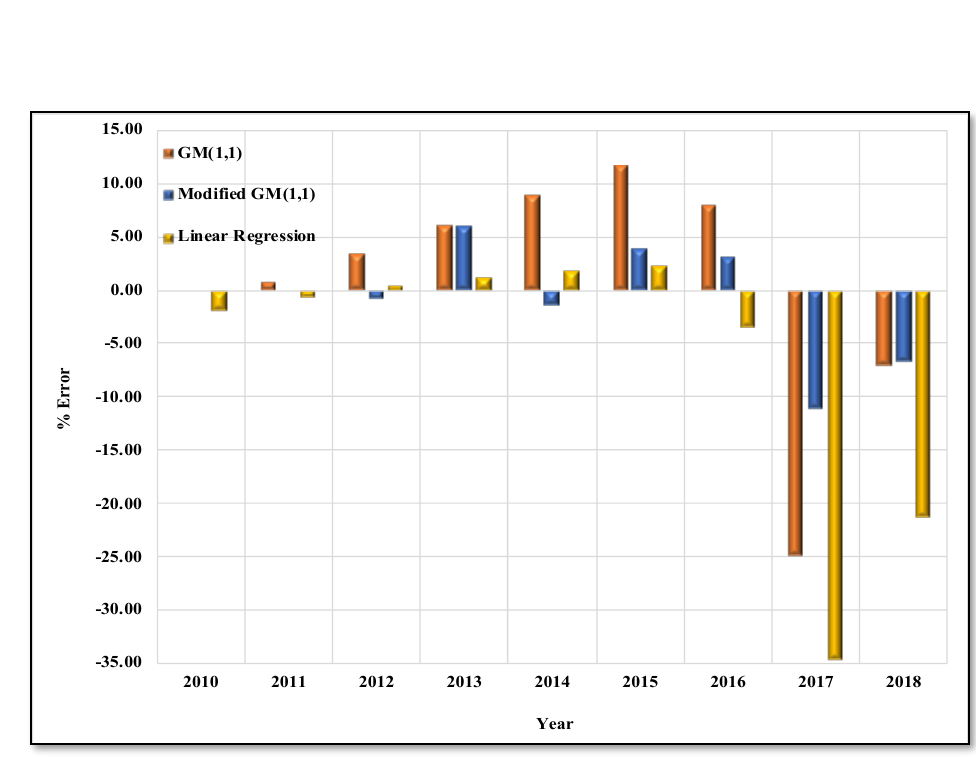
Figure 4. Trends of forecasted and target values.